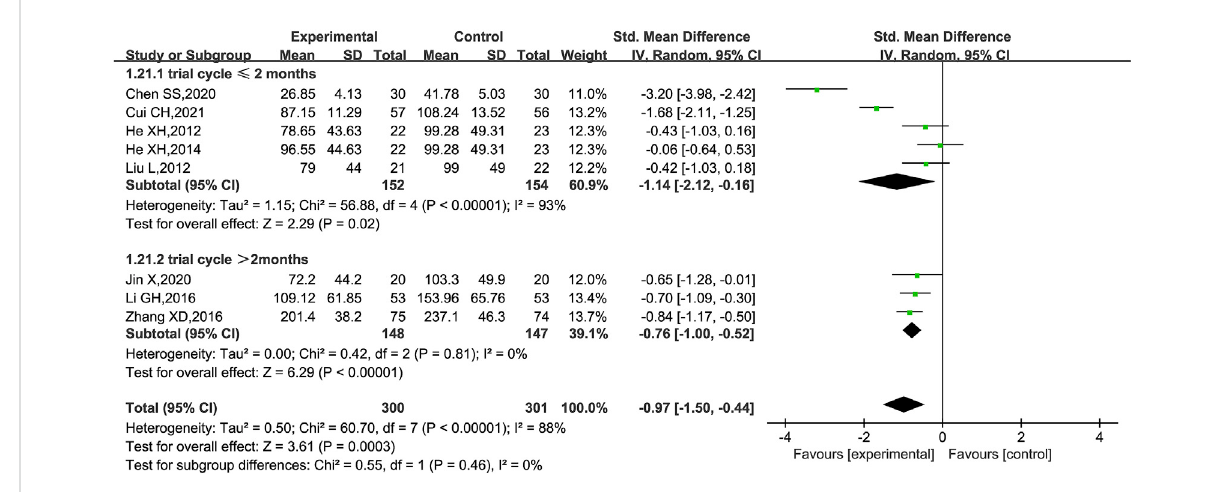
FIGURE 5 Forest plot of UAER for KLXC + Western medicine vs. Western medicine alone.